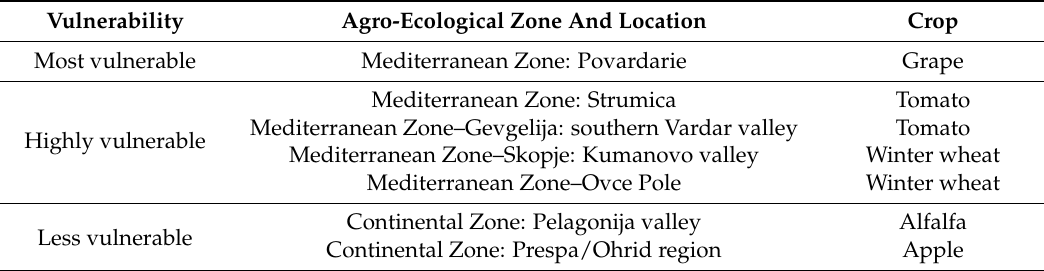
Table 2. Vulnerability of agricultural regions and crops in Macedonia to climate change by 2100. Vulnerability Agro-Ecological Zone And Location Crop Most vulnerable Mediterranean Zone: Povardarie Grape Mediterranean Zone: Strumica Tomato Mediterranean Zone–Gevgelija: southern Vardar valley Tomato Highly vulnerable Mediterranean Zone–Skopje: Kumanovo valley Winter wheat Mediterranean Zone–Ovce Pole Winter wheat Continental Zone: Pelagonija valley Alfalfa Less vulnerable Continental Zone: Prespa/Ohrid region Apple Source: